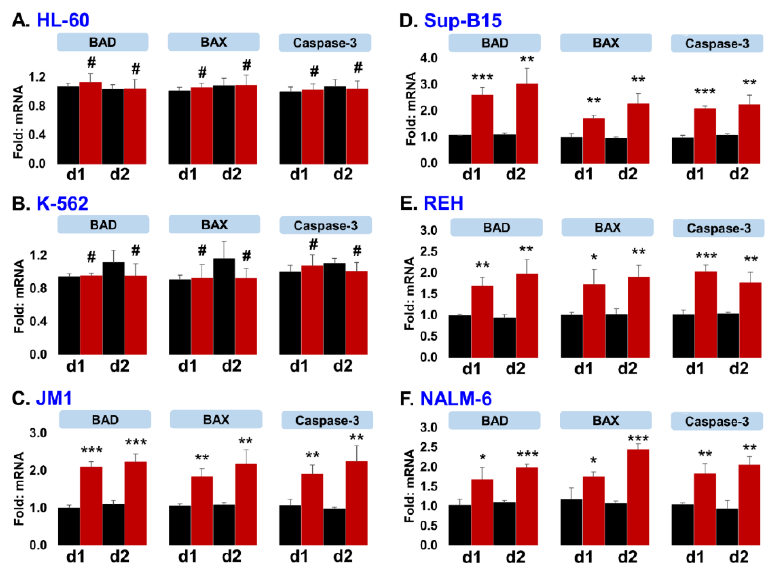
Figure 7. Exo-CD19 CAR exposure induces pro-apoptotic genes in CD19-positive B-cell leukemia. ( A , B ) The qPCR data show that Exo-CD19 CAR exposure could not induce pro-apoptotic genes (BAD, BAX, and Caspase-3) in CD19-negative cell lines (HL-60 and K-562). ( C – F ) The qPCR data demonstrate that Exo-CD19 CAR treatment induces pro-apoptotic genes (BAD, BAX, and Caspase-3) in CD19-positive cell lines (JM1, Sup-B15, REH, NALM-6). For quality and reproducibility purposes, five different batches of exosomes were utilized in the experiments ( n = 5). Statistical p -value (* p < 0.05, ** p < 0.01, *** p < 0.001), # represent not significant. Red bars demonstrate Exo-CD19 CAR exposure, and black bars demonstrate control Exo-WT. d1 represent day 1 and d2 represent day 2 exposure of target cells with Exo-WT/Exo-CD19 CAR.